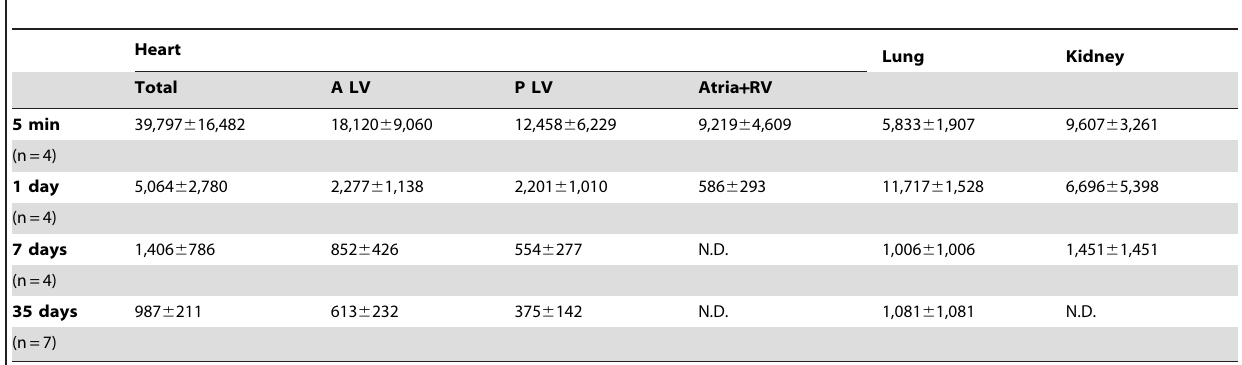
Values are means 6 SEM. A LV, anterior LV wall (including infarct and risk region); P LV, posterior LV wall; RV, right ventricle; N.D., non-detectable.